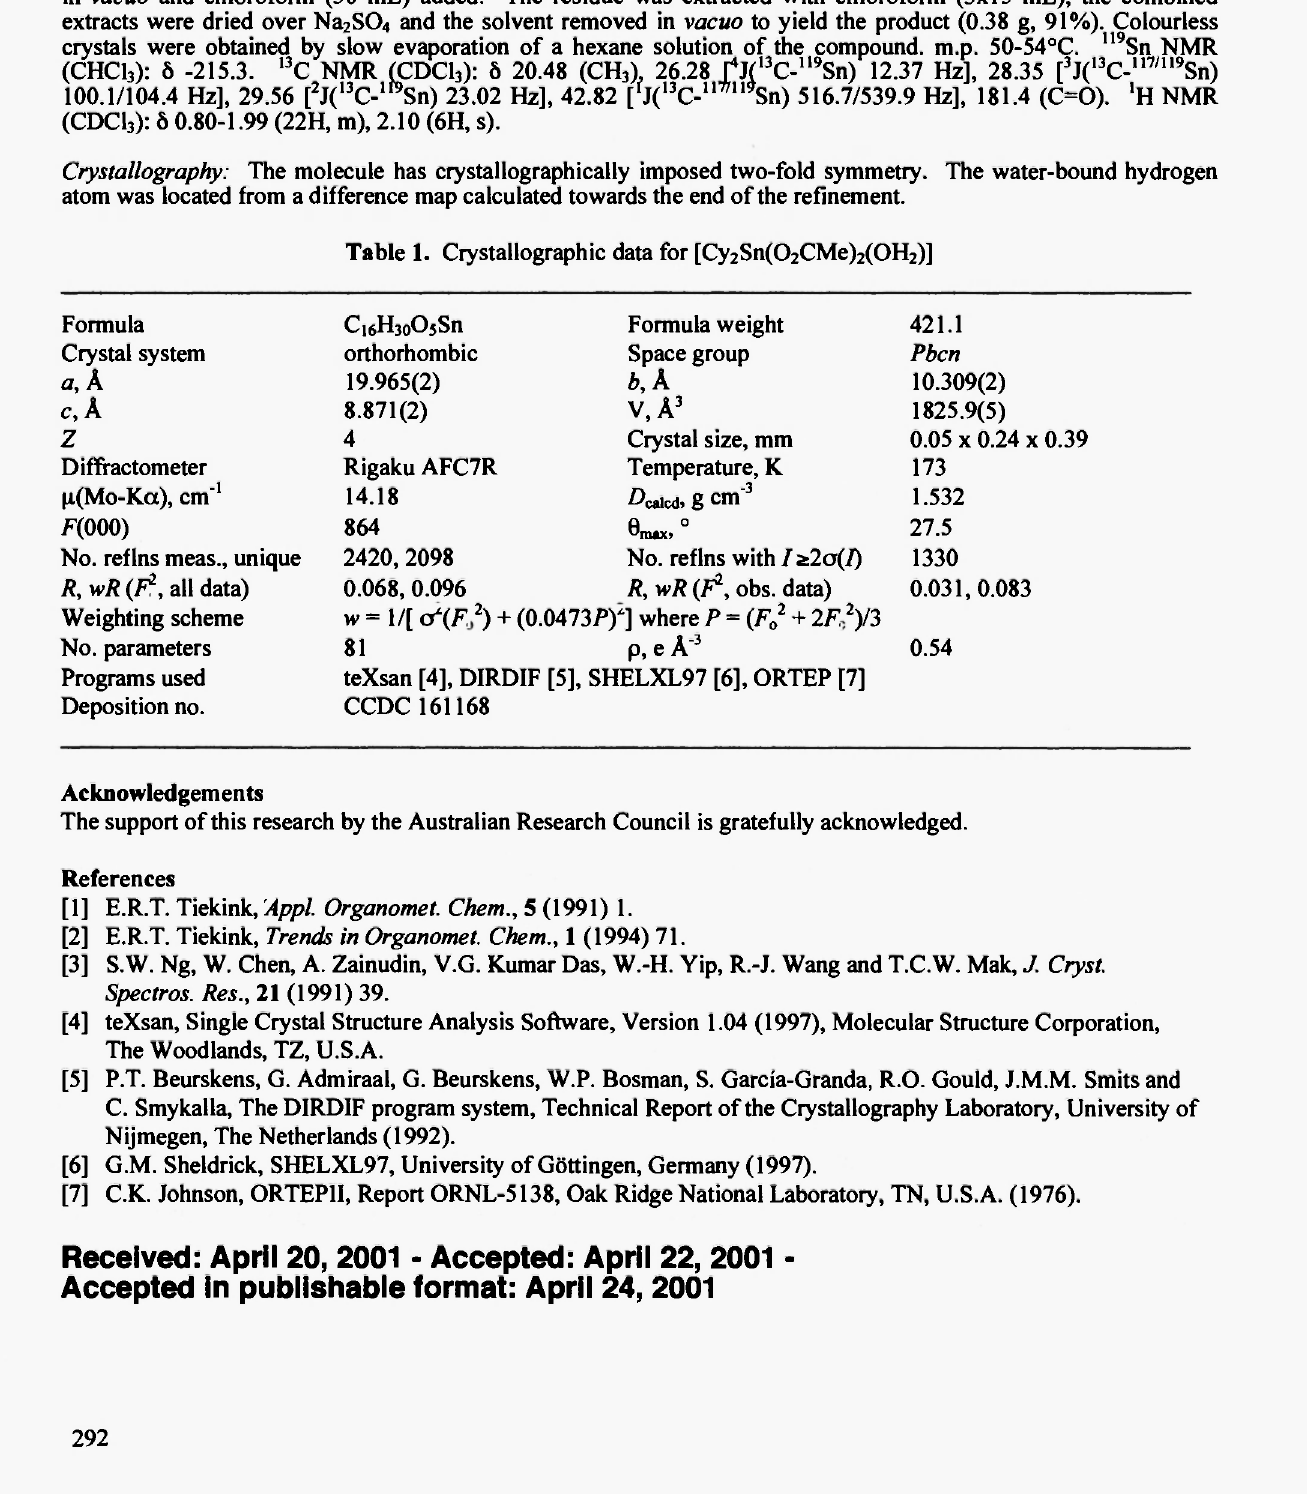
Sn(0 CMe) (0H 2 2 2 2